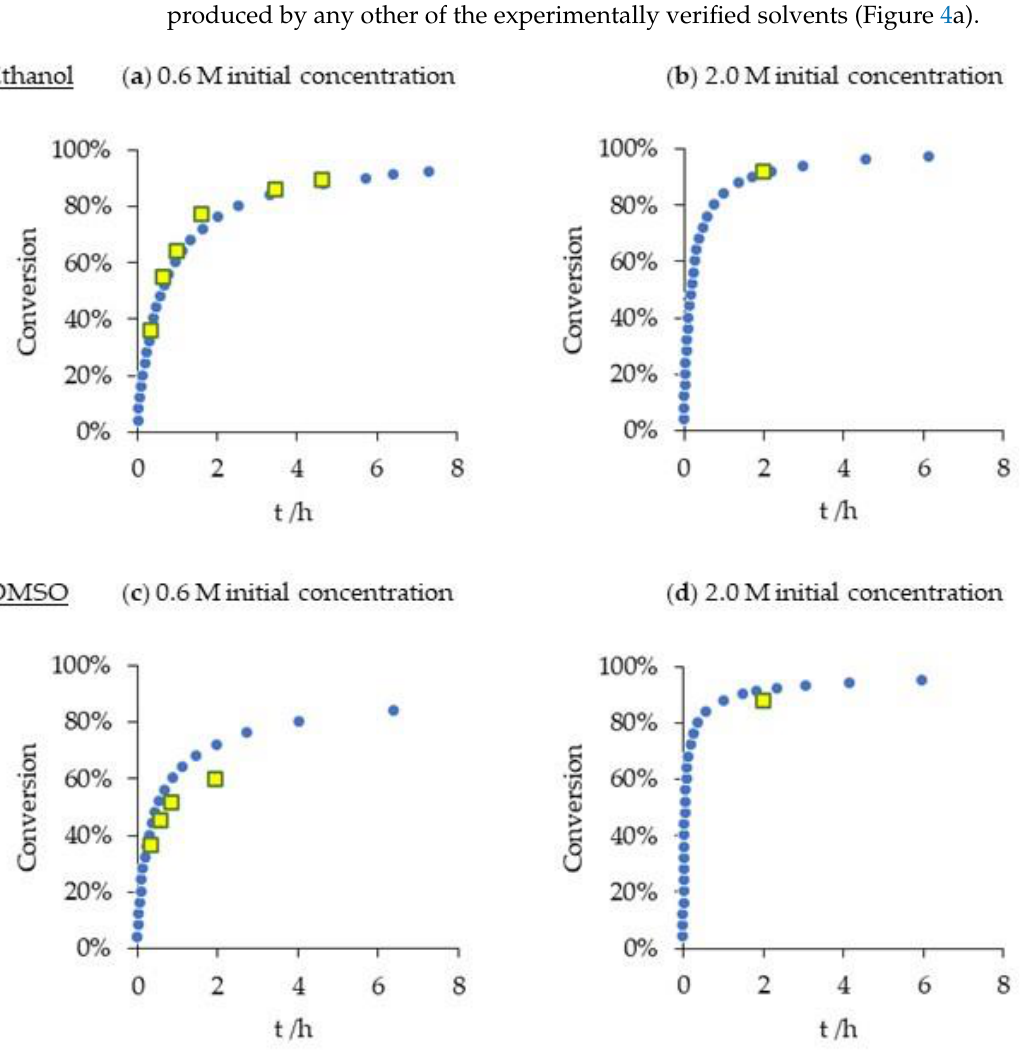
Figure 3. Aza-Michael reaction optimization. Blue (circular) data points are predicted conversions. Yellow (square) data points represent experimental data. ( a ) Reaction in ethanol with initial reactant concentrations of 0.6 M; ( b ) Reaction in ethanol with initial reactant concentrations of 2.0 M; ( c ) Reaction in dimethyl sulfoxide (DMSO) with initial reactant concentrations of 0.6 M; ( d ) Reaction in DMSO with initial reactant concentrations of 2.0 M.